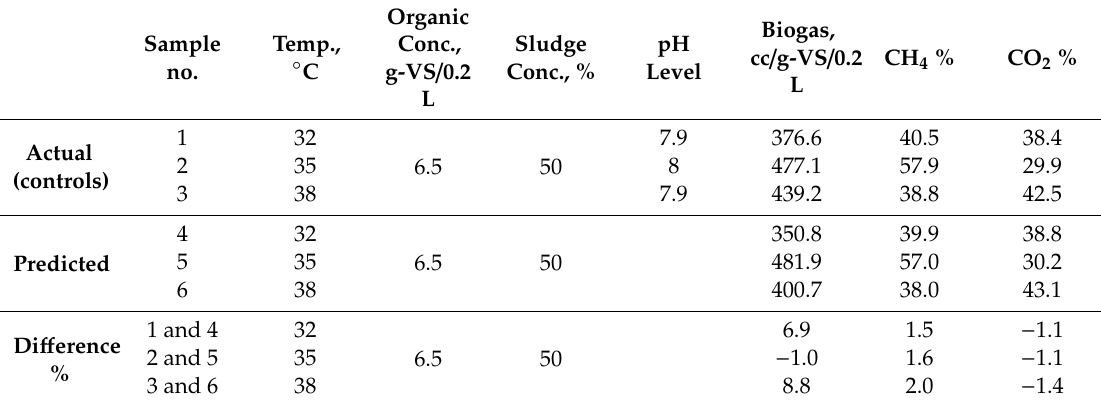
Table 8. A comparison between the results of the controls and the predicted